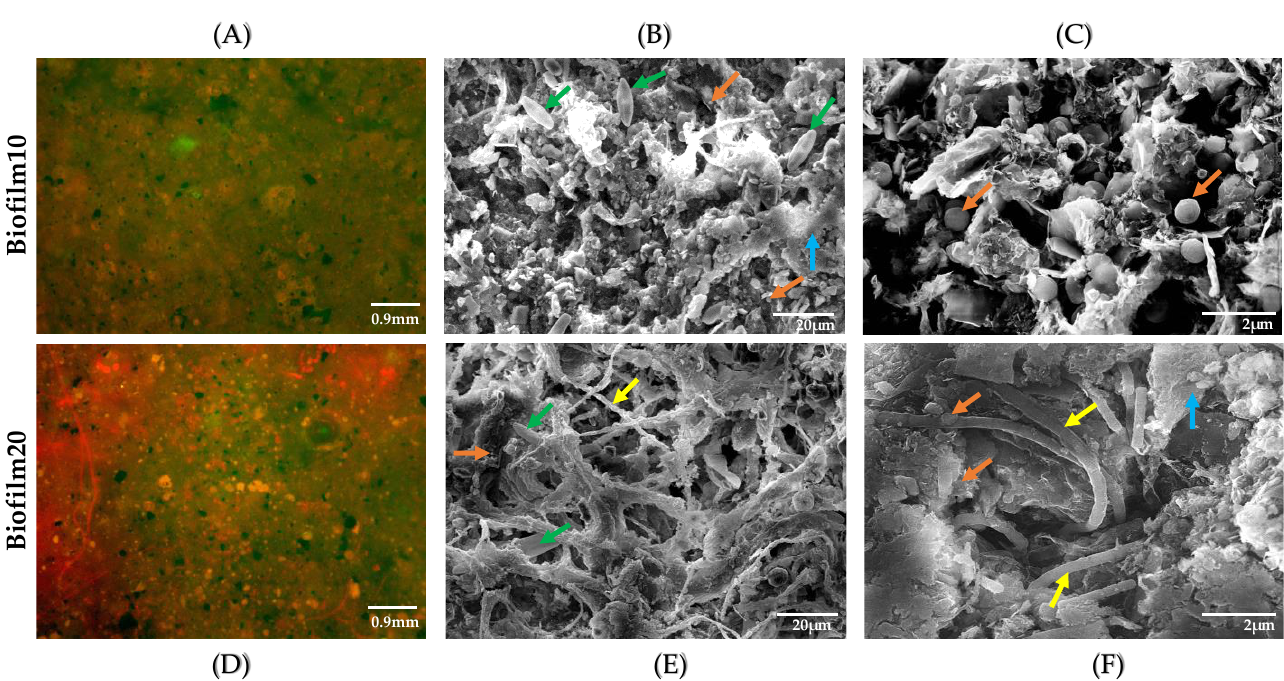
Figure 1. Viability of the cells was determined by LIVE/DEAD staining ( A , D ) at 200 × magnification (green, live; red, dead). SEM was utilized to visualize the status of biofilms at week 10 ( B , C ) and week 20 ( E , F ). ( B , C ) are different SEM images of Biofilm10 taken at different scales—20 and 2 µ m, respectively. Similarly, E and F are different SEM images of Biofilm20 taken at different scales—20 and 2 µ m, respectively. Green arrows represent Pinnularia (phylum = Ochrophyta), yellow arrows represent filamentous cyanobacteria, orange arrows represent Choricystis (phylum = Chlorophyta), and blue arrows indicate EPS mixed with mineral particles. Biofilm10 corresponds to 10-week-old biofilms; Biofilm20 corresponds to 20-week-old biofilms. Note that only the top layer of biofilms was sampled for LIVE/DEAD staining and SEM imaging.